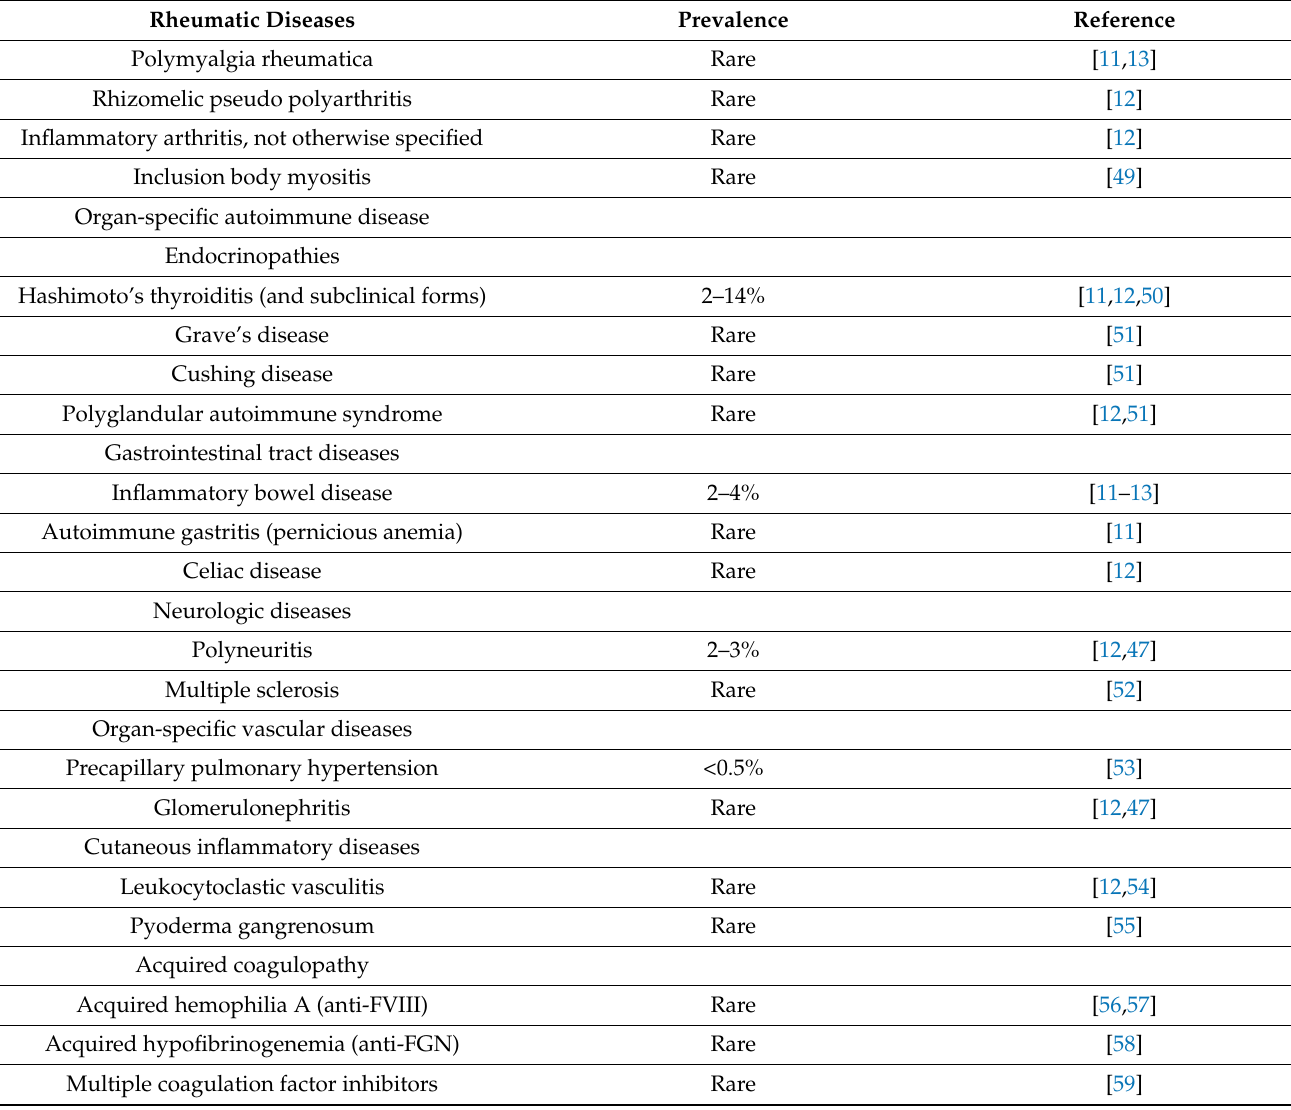
FGN: fibrinogen. FVIII: coagulation factor VIII. LGLL: large granular lymphocytic